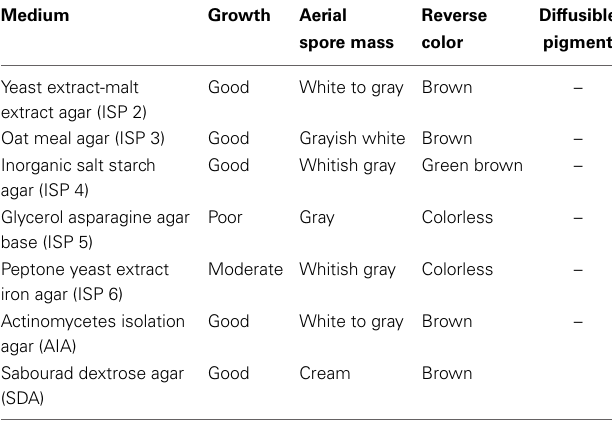
Table 1 | Cultural characteristic of Streptomyces sp. MN